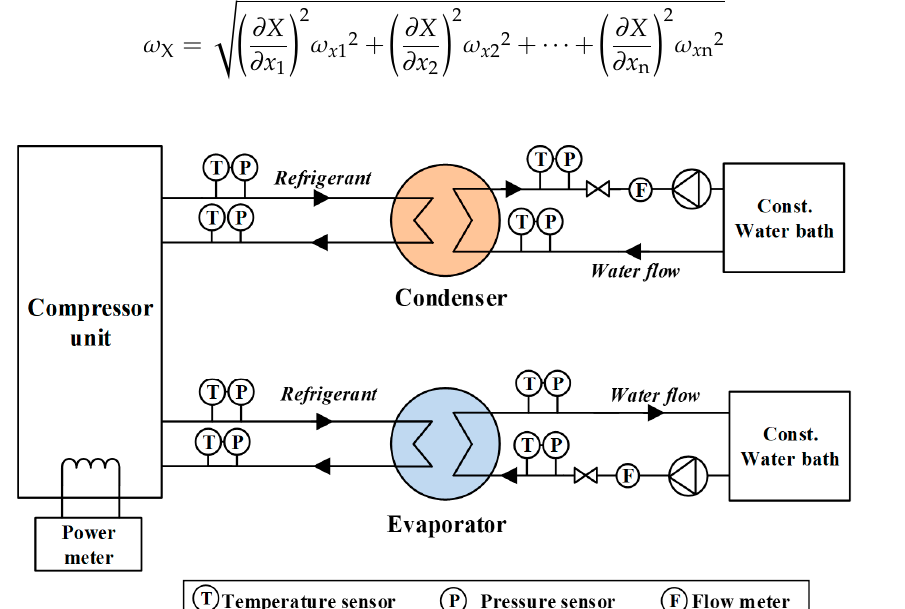
Figure 5. Experimental system for performance test of double pipe heat exchangers.